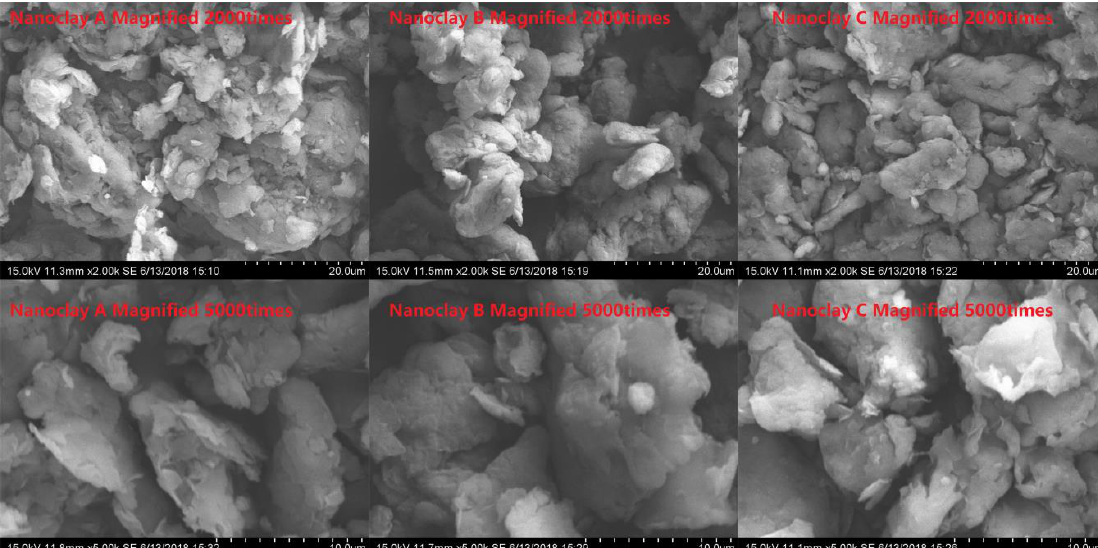
Figure 2. Nanoclay morphology Table 1. General information of selected nanoclay additives.